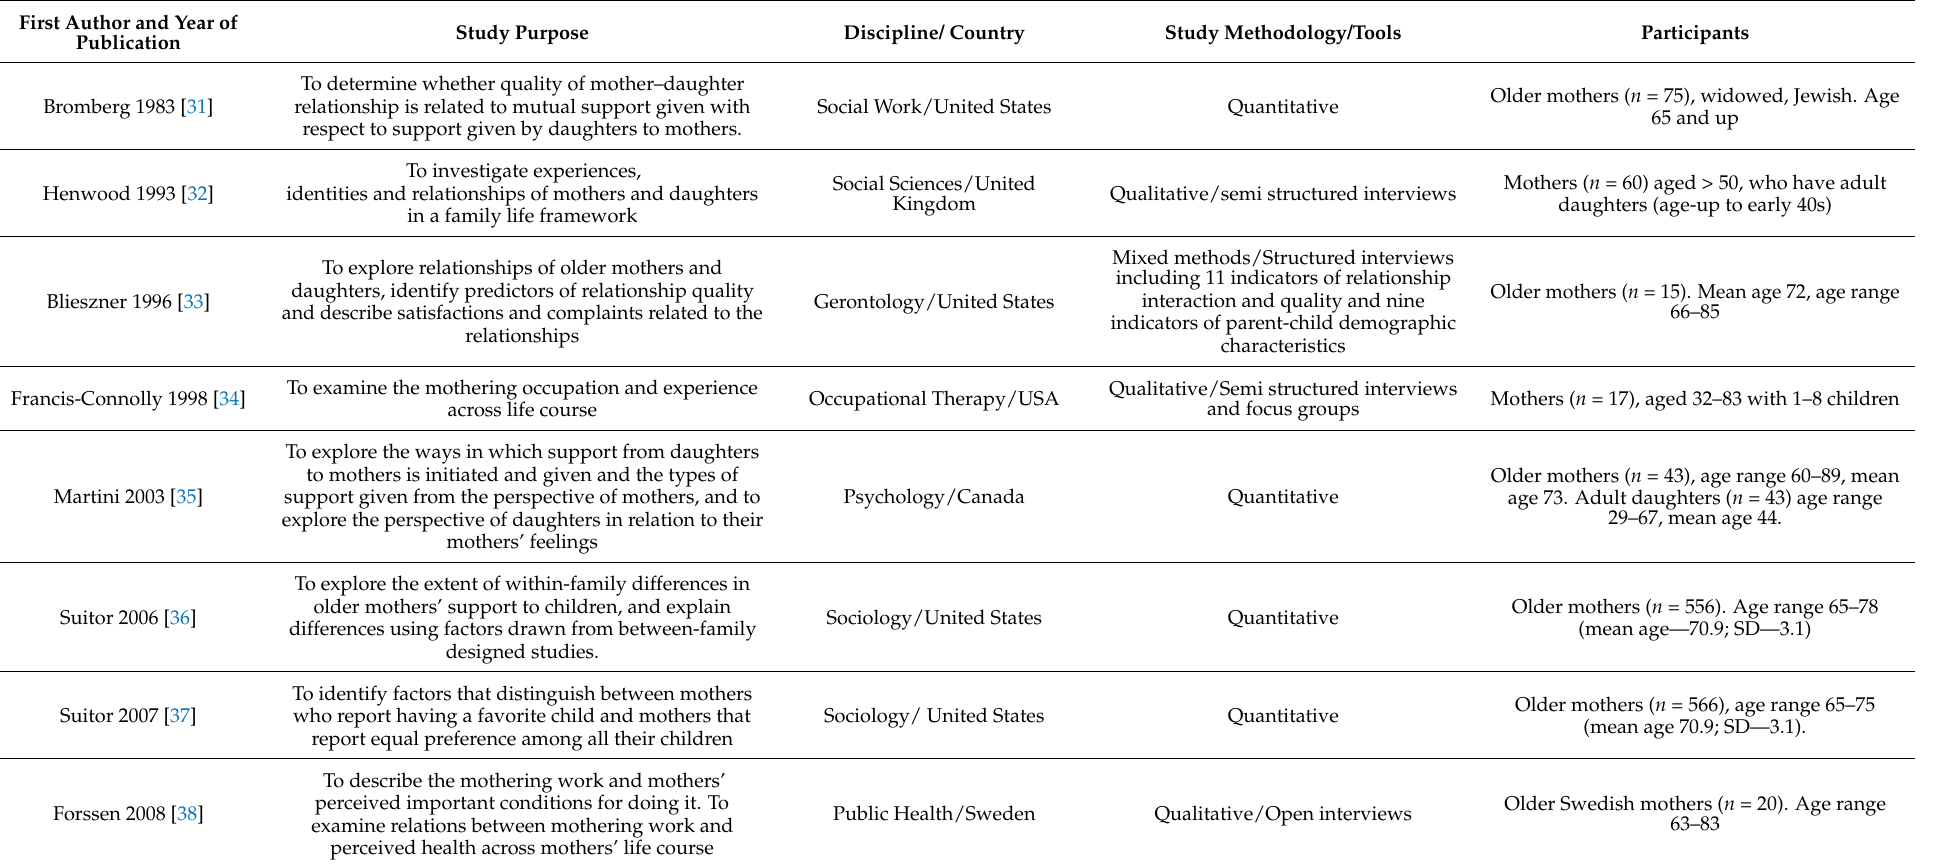
Table 1. Description of the 14 articles included in